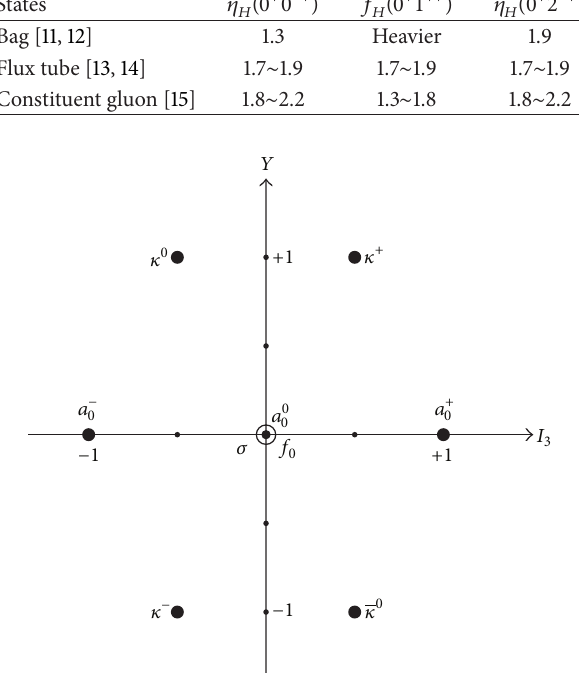
Table 2: The masses predicted for 3 1 𝑆 0 ( 𝜂 󸀠 ), 2 3 𝑃 1 ( 𝜂 󸀠 ), 1 1 𝐷 2 ( 𝜂 󸀠 ), and 𝜂 ) in [20, 25–27]. The value denoted by “ † ” was predicted for 2 1 𝐷 2 ( the mass of isovector 2 1 𝐷 2 state in [20].